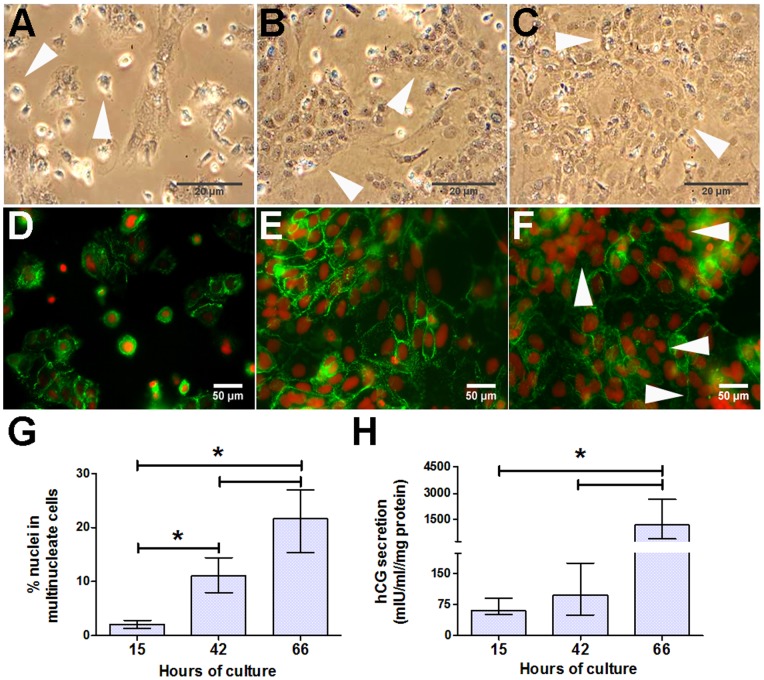
Characterization of placental cytotrophoblasts in culture.Representative phase contrast images of cytotrophoblasts at (A) 15 h, (B) 42 h and (C) 66 h depicting cytotrophoblast morphological differentiation in culture (scale bar 20 µm), together with corresponding immunofluorescent desmoplakin-staining (green) and nuclear counterstain (red; scale bar 50 µm) in D, E, F respectively. Arrows show different stages of cytotrophoblast differentiation: in (A) mononucleate cells, (B) multinucleate cell aggregates and (C, F) multinucleate syncytial-type cells. G: The % of cytotrophoblast nuclei in multinucleate cells depicting multinucleation and morphological differentiation (n = 15 placentas) at 15, 42 and 66 h in culture. H: Cytotrophoblast β-hCG secretion depicting biochemical differentiation (n = 16 placentas); *p<0.05; Friedman’s test with Dunn’s post hoc test. Data are median ± IQR.